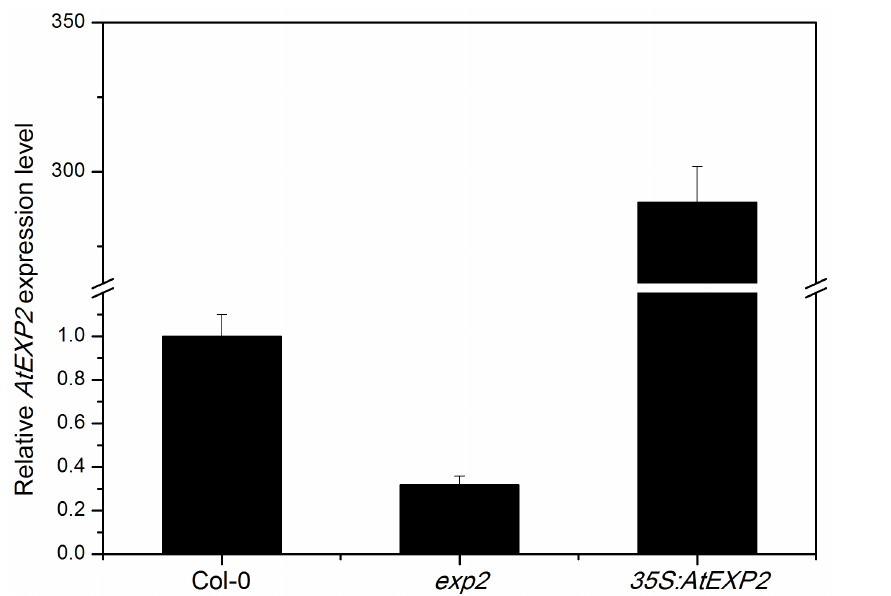
Figure 2. Relative expression levels of AtEXP2 in exp2 and 35S:AtEXP2 line. Seeds of wild type, exp2 and 35S:AtEXP2 overexpression line were harvested for RNA extraction after 24 h imbibition in water. Transcript abundance was measured by real-time RT-PCR and the values were normalized against the levels of TUB2 as a housekeeping gene. Error bars represent SD.